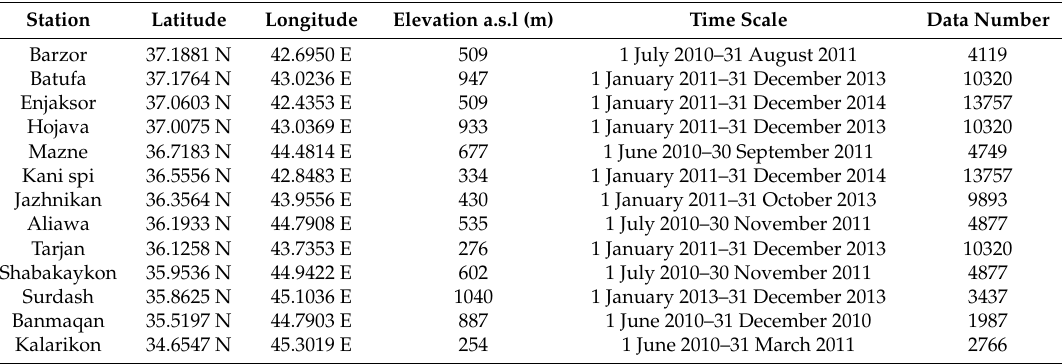
Table 1. Description of processed data of ten-minute global horizontal irradiance measured by a CMP6 Kipp and Zonen Pyranometer for the tower stations.